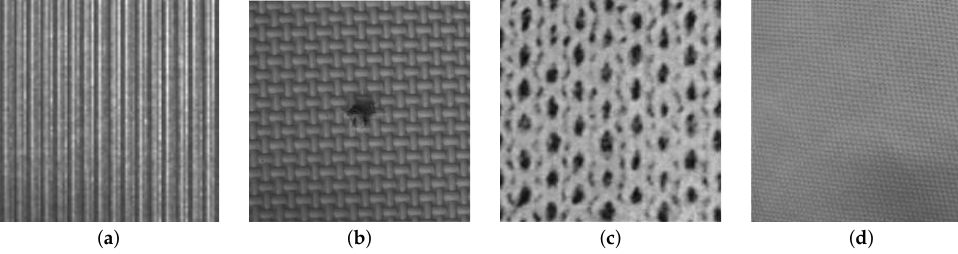
Figure 2. Several examples of structural textures: ( a ) milled surface; ( b ) bamboo weave; ( c ) fabric, coarse appearance (p1); ( d ) fabric, fine appearance